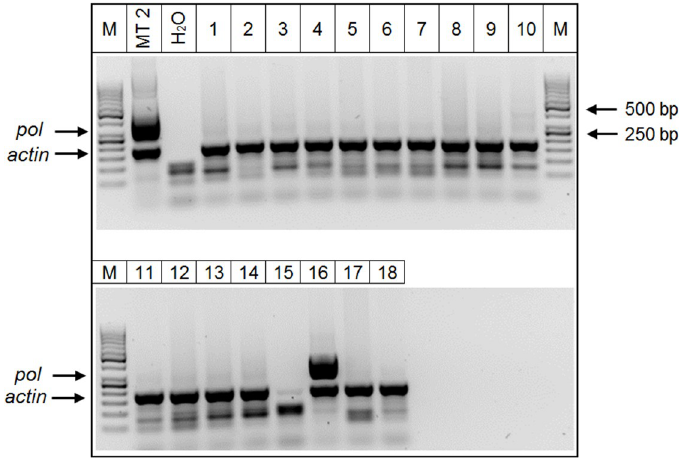
Fig 4. nPCR with pol HTLV-1 and actin co-amplification. MT2 (positive control), H 2 O (negative control), lines 1–18: samples with suspicion of malignancy. The arrows point to the band of pol and actin amplification and 50 bp DNA Ladder